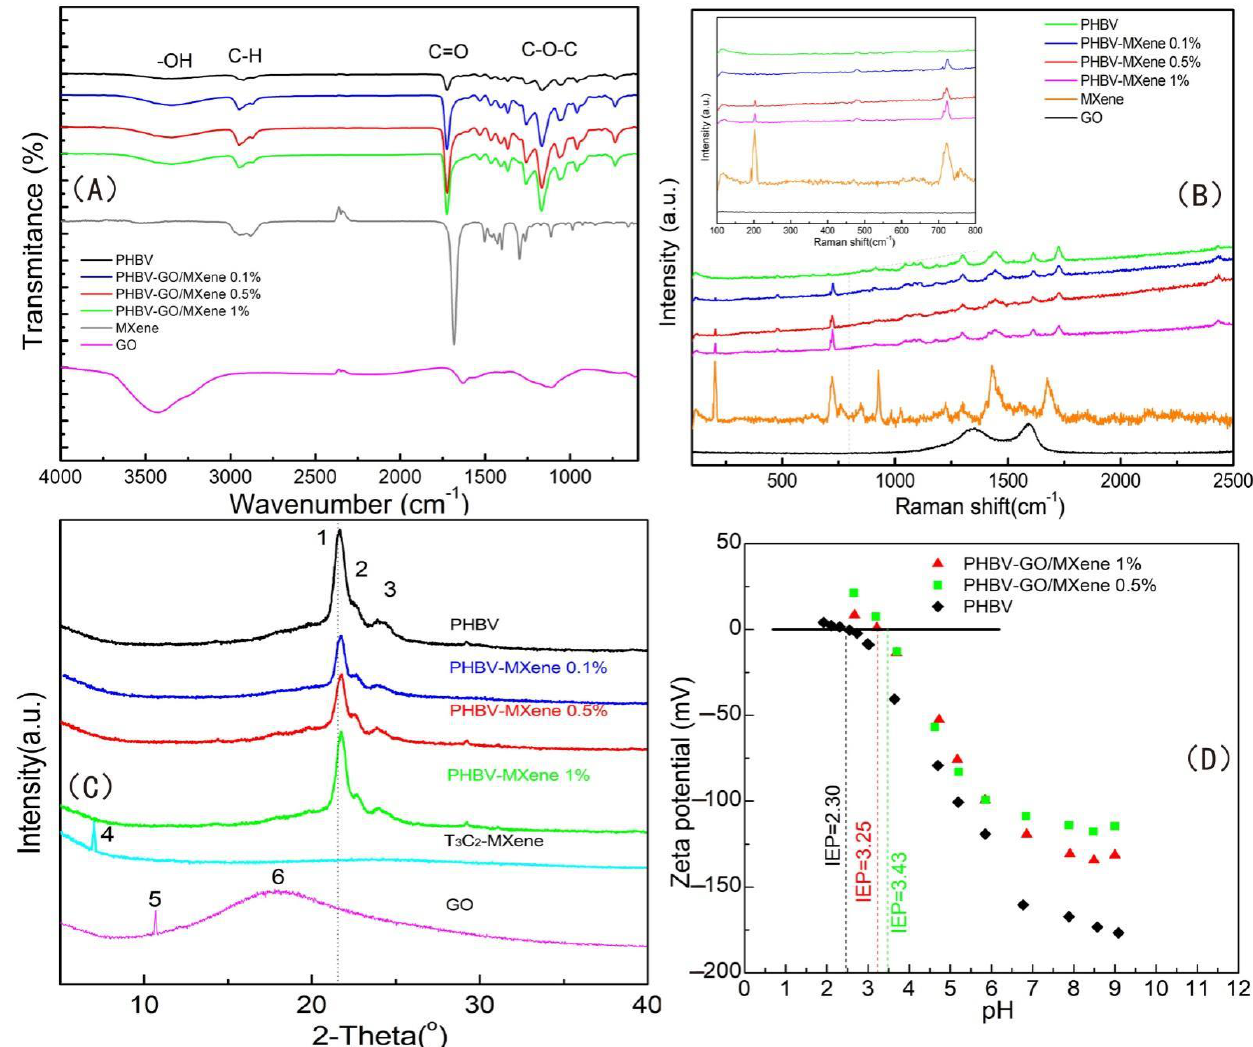
Figure 5. FT-IR ( A ), Raman ( B ), and XRD ( C ) spectra of PHBV, GO, MXene, PHBV — GO/MXene 0.1%, PHBV — GO/MXene 0.5%, and PHBV — GO/MXene 1% composite membranes. Zeta potential ( D ) of PHBV, PHBV — GO/MXene 0.5%, and PHBV — GO/MXene 1% composite membranes.